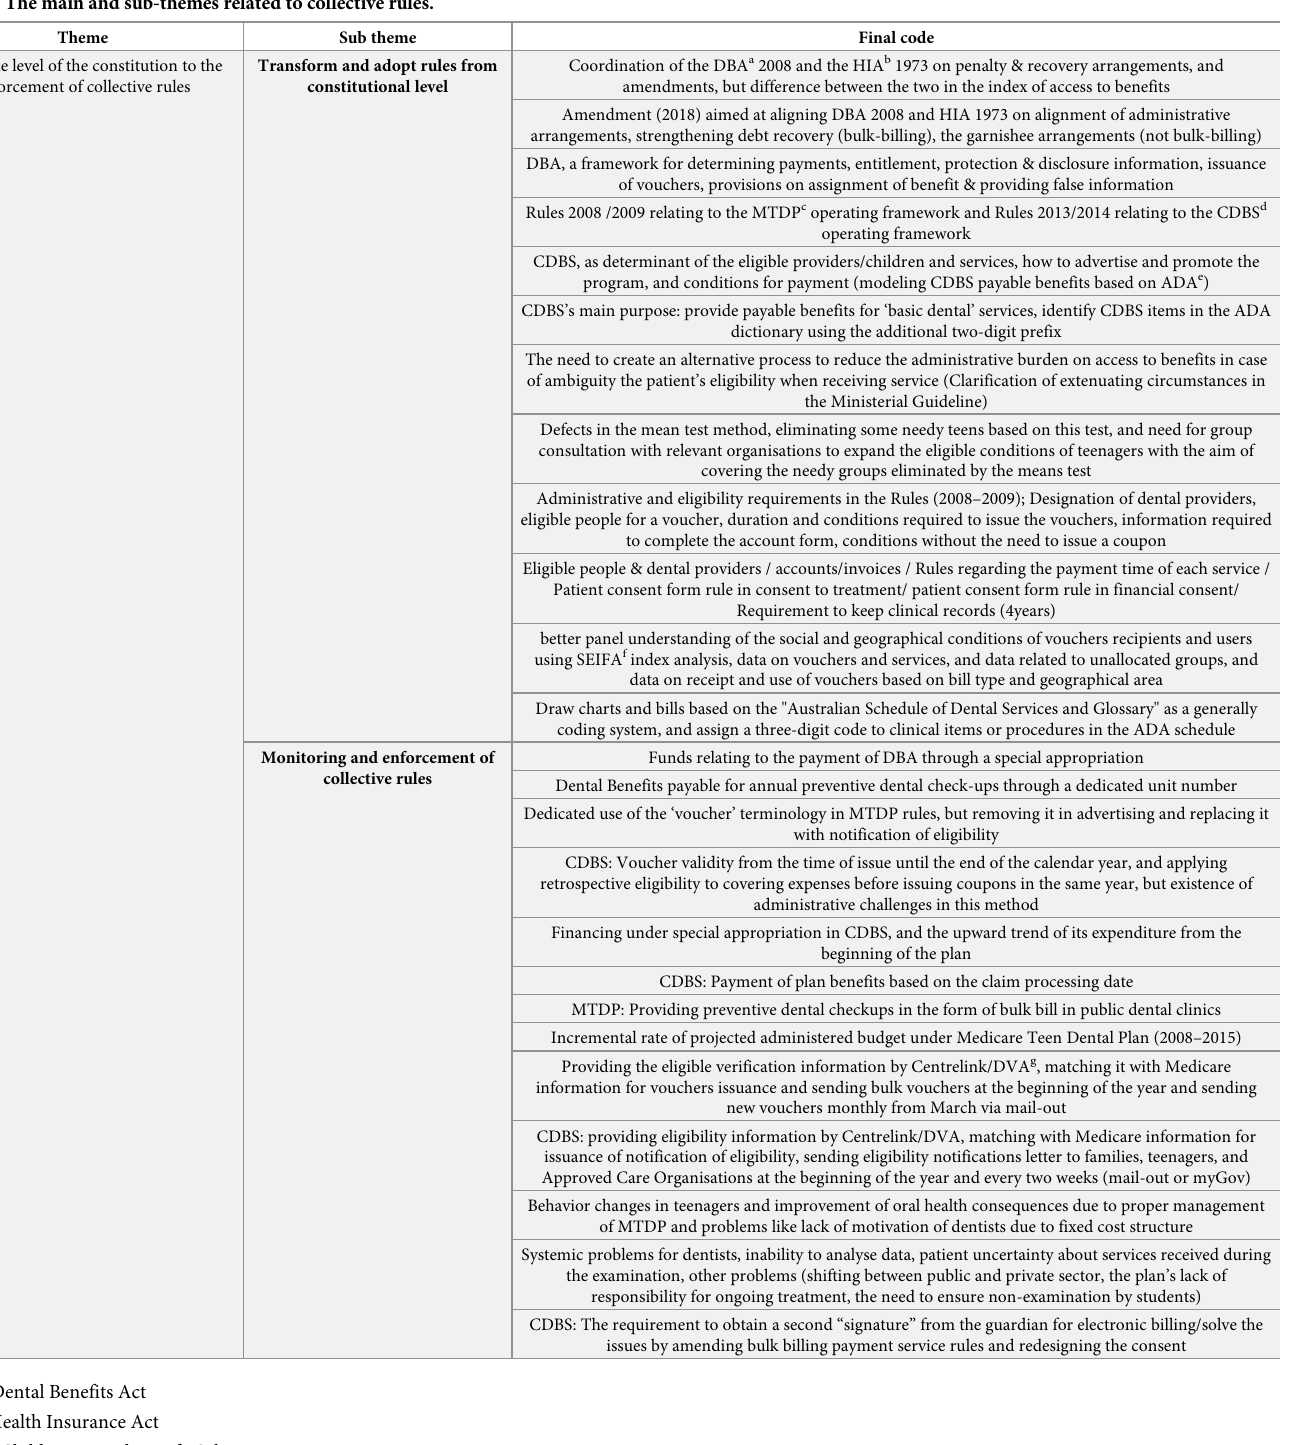
Table 2. The main and sub-themes related to collective